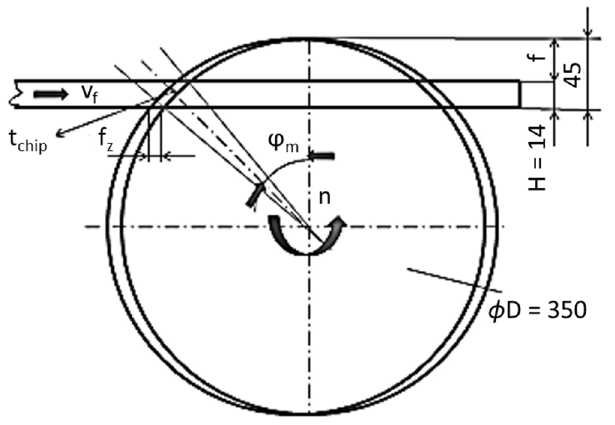
Figure 3. Average chip thickness, cutting trajectory through the plate thickness and cutting kinematics.